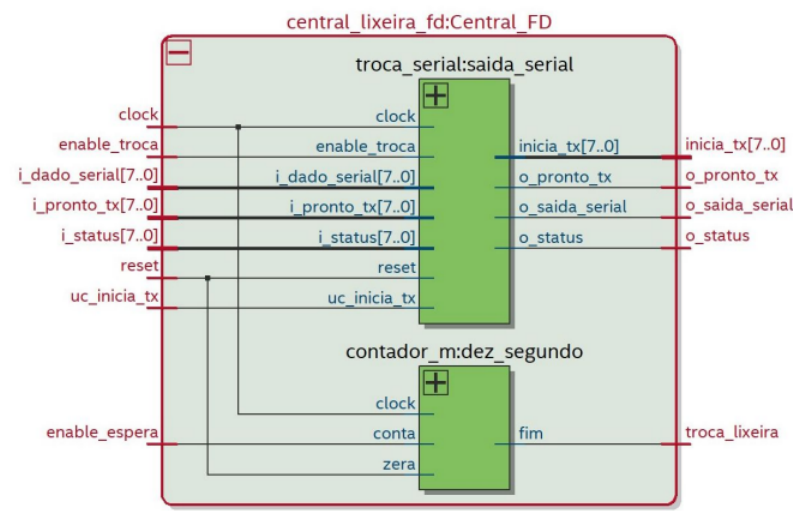
Figure 12. Data flow of the control component.